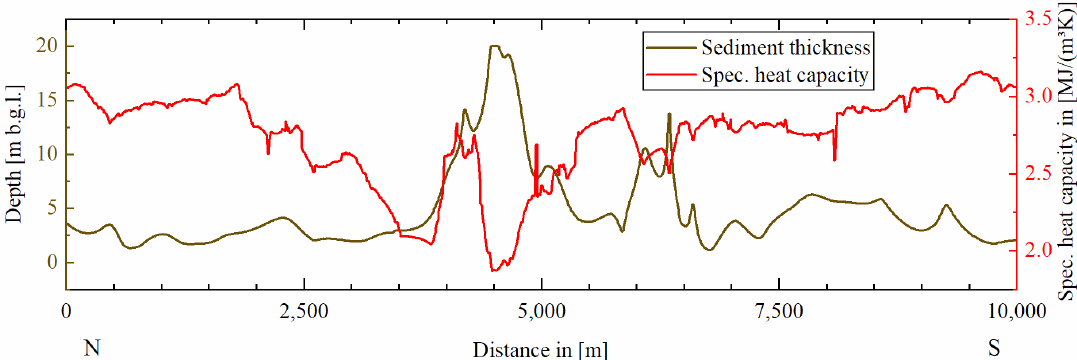
Figure 9. Cross-section for the sediment thickness and the specific heat capacity. In comparison to the unsaturated zone, only an unclear correlation between sediment thickness and specific heat capacity can be seen.